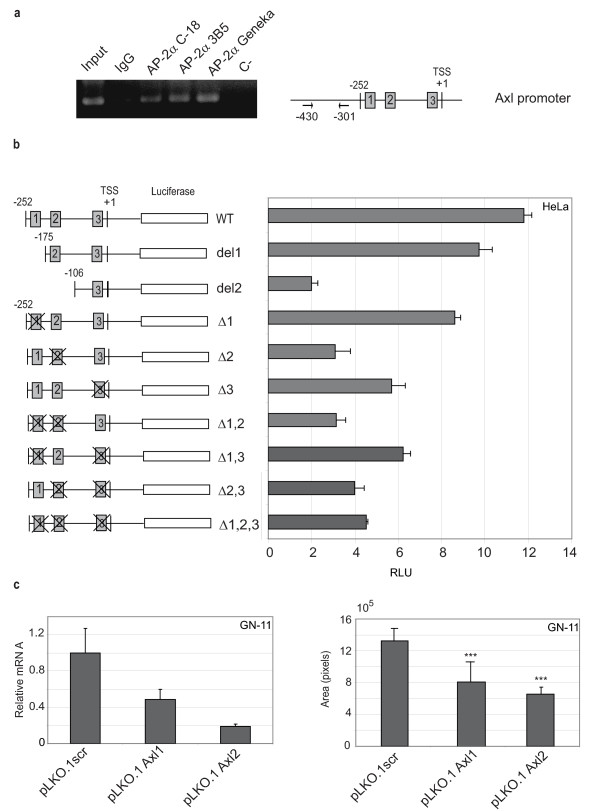
AP-2α regulates GN-11 neuron migration via Axl. (a) Three AP-2α binding sites were identified in the regulatory region (-1000/+1, +1 is the transcription start site (TSS)) of the mouse Axl gene (site 1 = GCCCCAAGG; site 2 = GCCAGGGGC; site 3 = GCCCAGGGG) and verified by chromatin immunoprecipitation (ChIP) using two primers at the indicated positions. Chromatin from GN-11 cells was cross-linked to proteins, extracted and immunoprecipitated with either AP-2α Abs (C-18 or 3B5 or Geneka) or non-specific IgG (negative control). DNA was analysed by polymerase chain reaction (PCR), using primers flanking the AP-2α putative binding sites in the Axl promoter. Input: not immunoprecipitated DNA. The experiment was repeated three times and one representative experiment is shown. (b) Schematic representations of the mouse Axl promoter fragments cloned into the pGL3-basic vector are shown (left panel). HeLa cells were transiently transfected with the various constructs together with a Renilla normalization vector (pRL-TK) and 48 hours later, luciferase activity was measured and normalized against Renilla activity. The experiment was performed in triplicate and repeated two or three times. One representative experiment is shown (right panel). RLU = relative luciferase units. (c) The effect of Axl down-regulation on cell movement was assessed for lentivirus-infected GN-11 neurons expressing either pLKO.1scr (scrambled) or pLKO.1Axl1 or pLKO.1Axl2. Axl down-modulation was evaluated by quantitative real-time PCR (left panel) while transwell migration (right panel) was analysed by plating the cells in serum-free medium in the upper chamber and allowing the cells to migrate over 10% foetal calf serum (FCS) medium for 18 hours through a porous membrane. The area occupied by migrating cells is shown. The experiments were performed in triplicate and repeated twice. Representative experiments are shown. The differences were statistically significant as measured by a two-tailed Student's t-test (***, p < 0.05). (In (b) and (c) the bars represent ± standard deviations.)